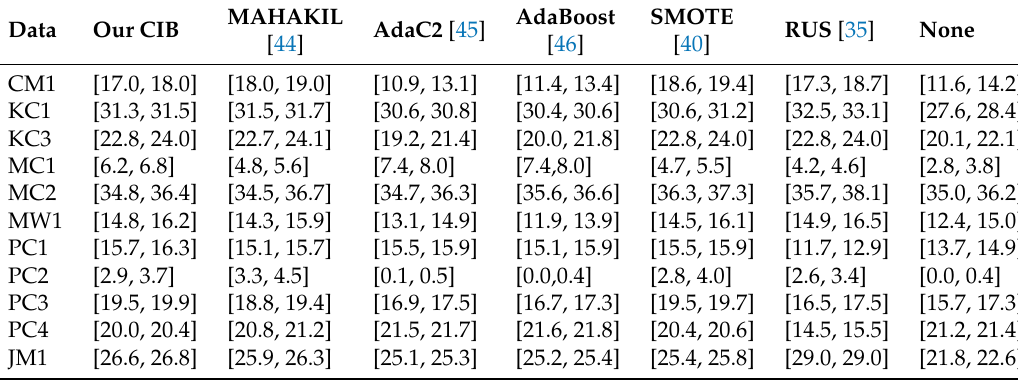
Table 9. 95% confidence interval of AGF for CIB and the baselines on 11 NASA datasets. Data